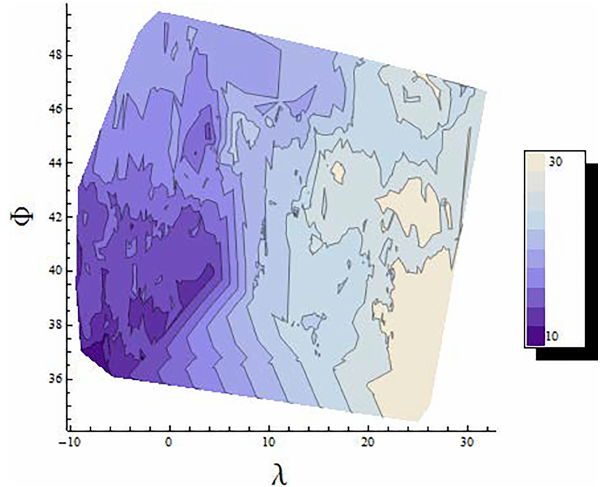
Figure 5. Longitude difference plot for each location set. The axes are contemporary latitude and longitude.